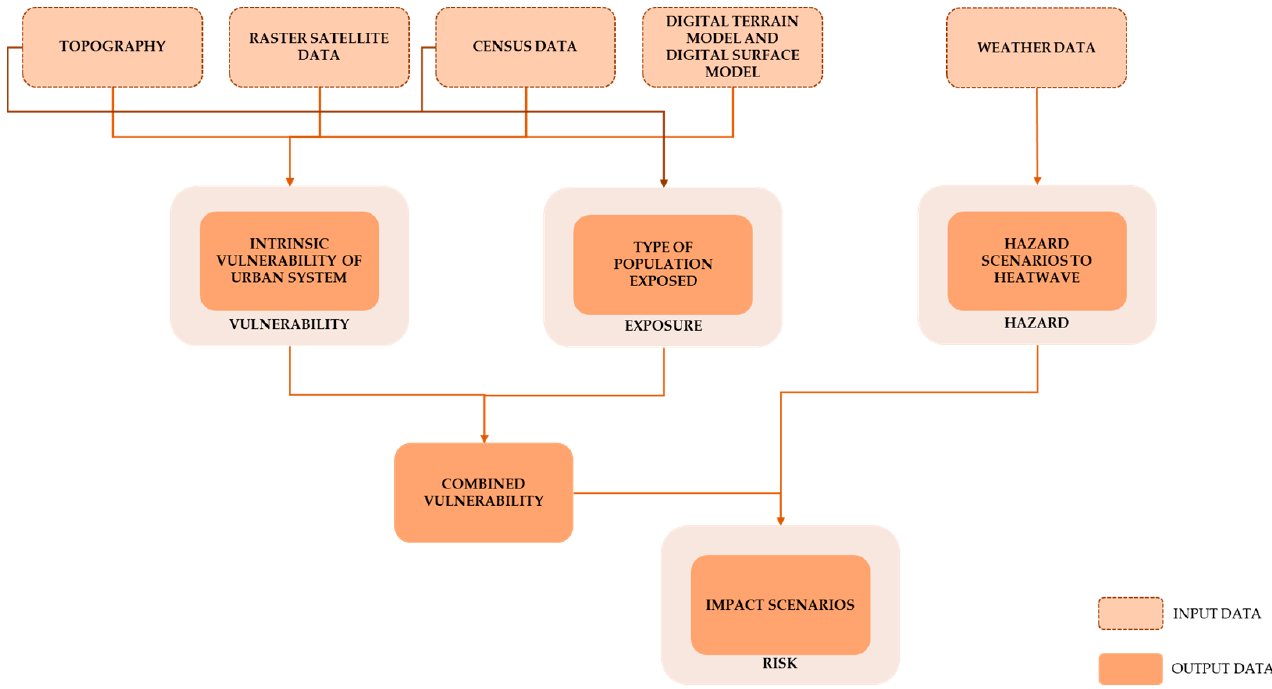
Figure 1. PLANNER model workflow.